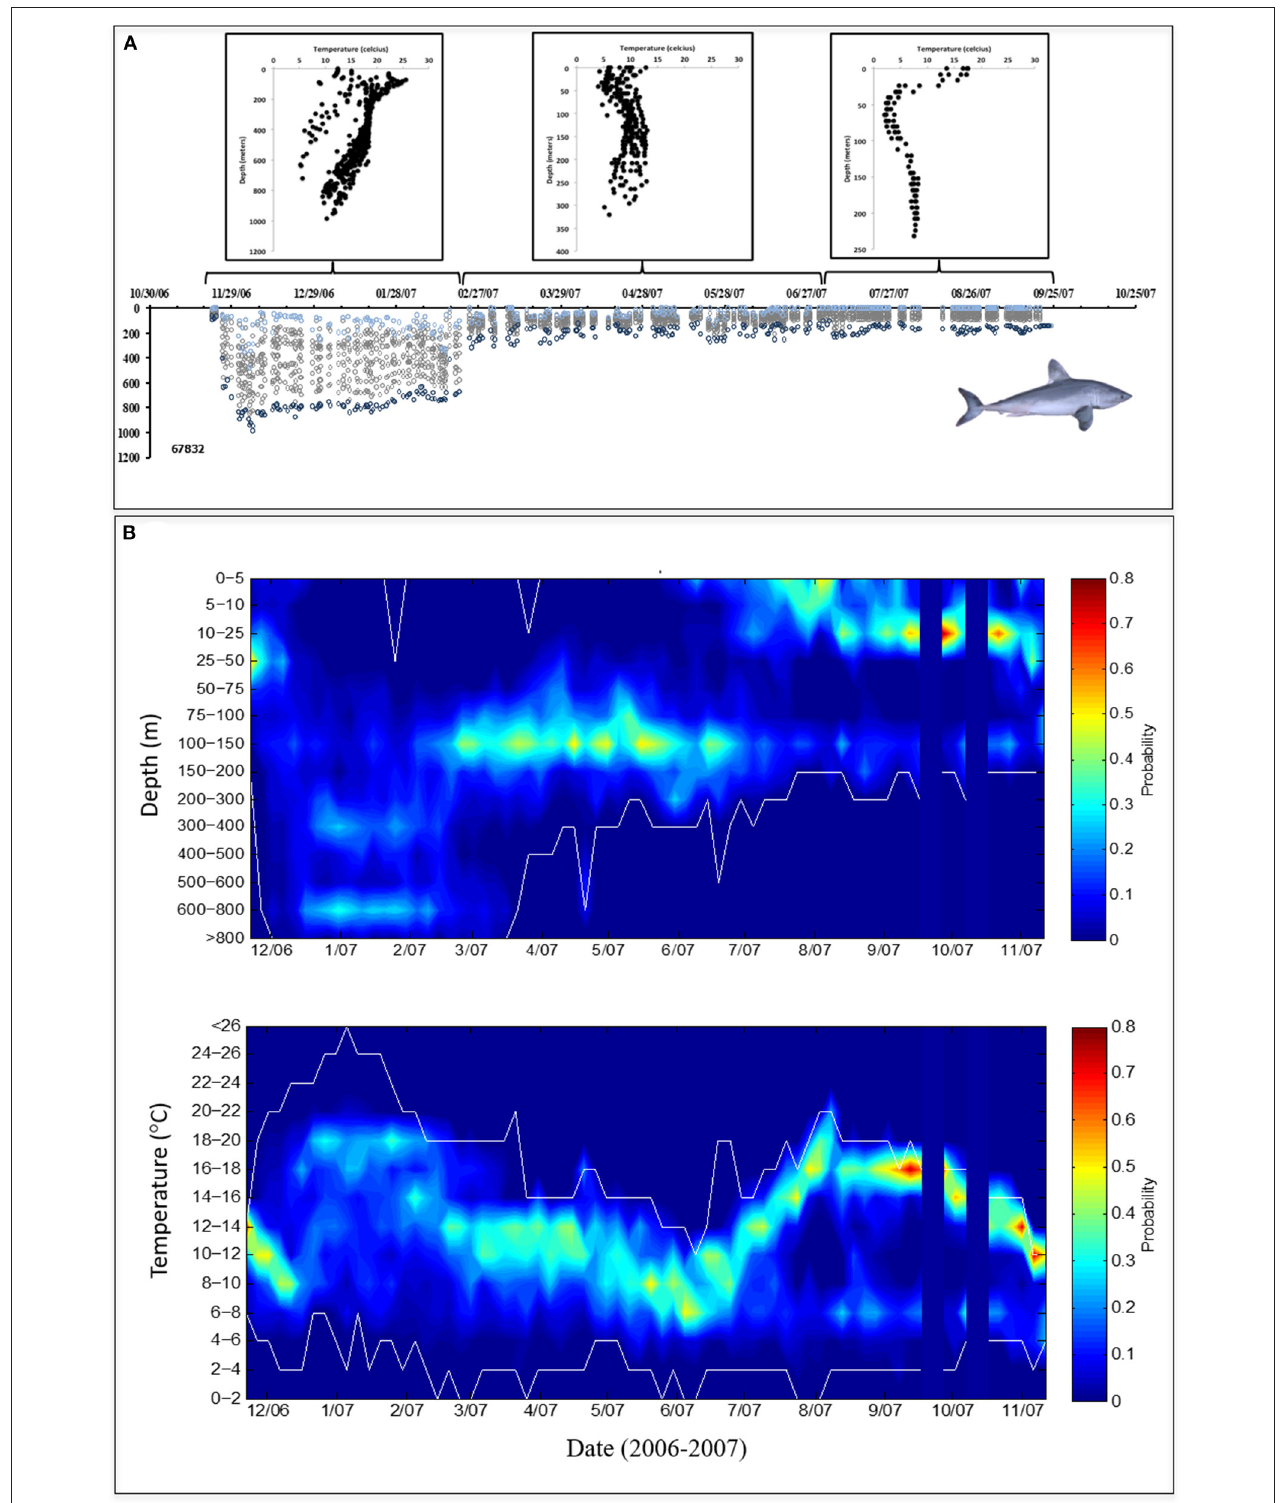
FIGURE 4 | (A) Vertical behavior of a representative “diver” porbeagle (Shark 9, PTT 67832) showing depth-temperature profiles at 3-month intervals (upper) corresponding to daily depth observations (lower) comprised of minimum (light blue circles), maximum (dark blue circles), and intermediate (gray circles) depths. (B) Contoured probability plots of all depth (upper) and water temperature (lower) data collected from porbeagles classified as divers ( n = 10); white lines indicate upper and lower limits of the data and blue vertical bars indicate areas of missing data.